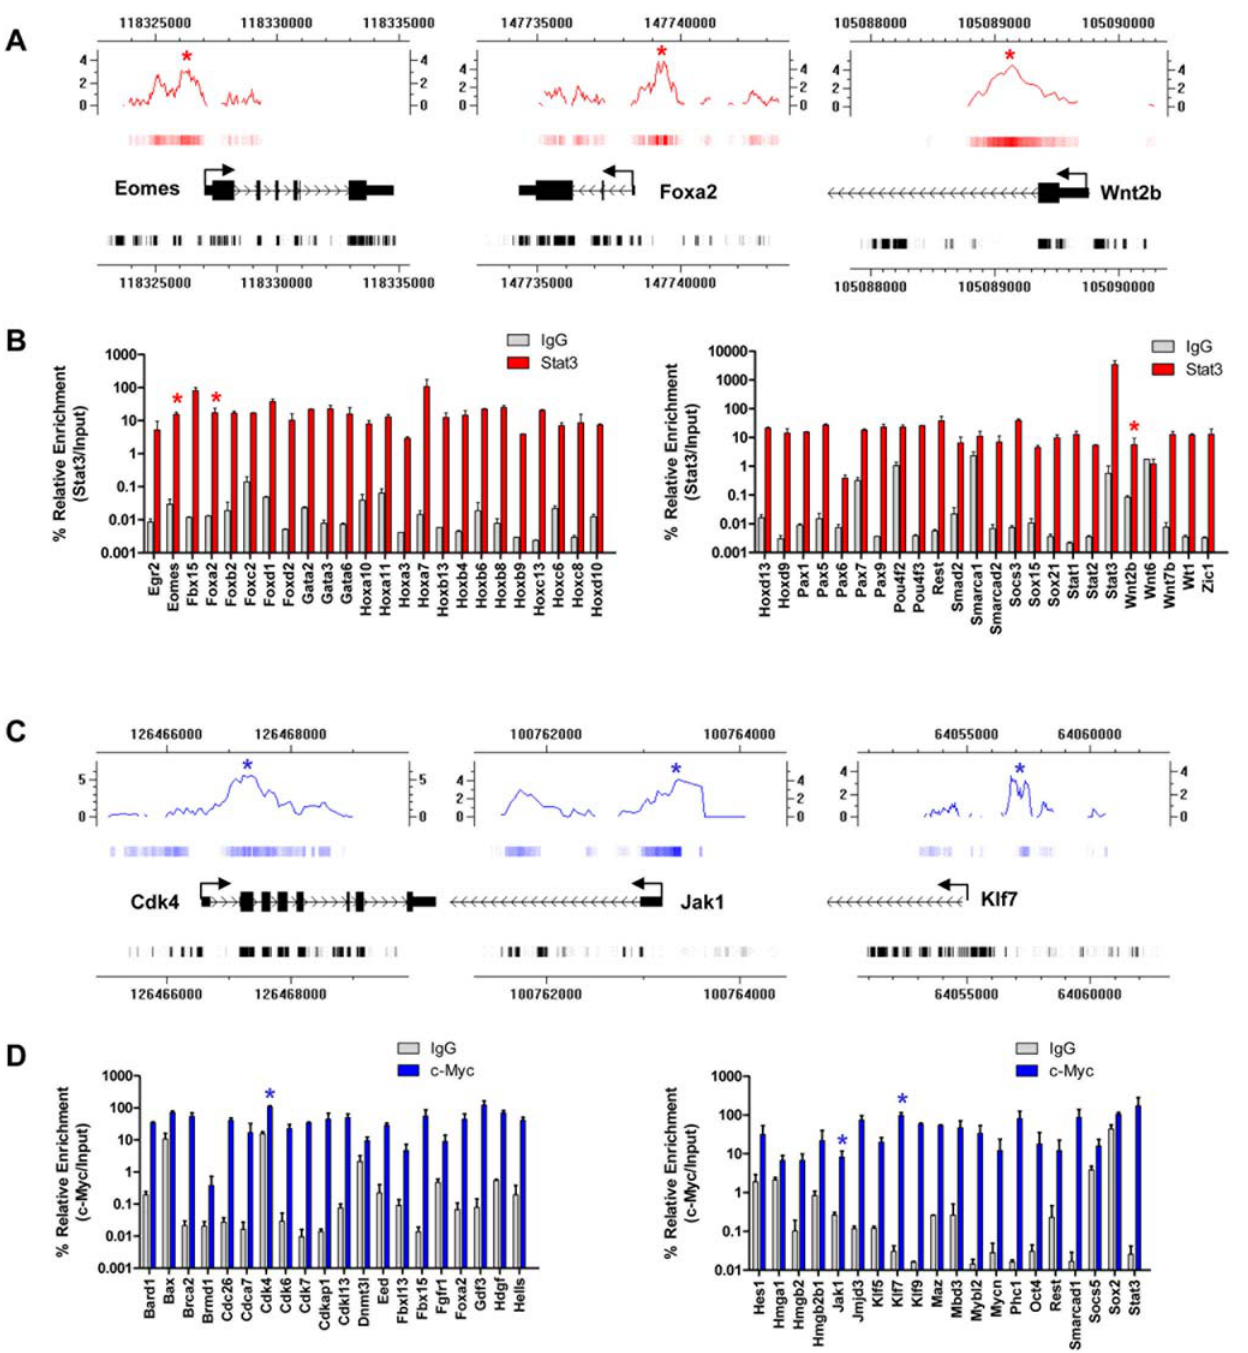
Figure 3. Q-PCR analysis of Stat3 and c-Myc ChIP-enriched regions. (A) Representative Stat3 genomic binding sites confirmed by Q-PCR. Red stars denote ChIP-chip enriched DNA sequences that were amplified using Q-PCR. (B) Confirmation of Stat3-ChIP enriched TF binding sites by Q-PCR. (C) Representative c-Myc genomic binding sites confirmed by Q-PCR. Blue stars denote ChIP-chip enriched DNA sequences that were amplified using Q-PCR. (D) Confirmation of c-Myc-ChIP enriched TF binding sites by Q-PCR. Q-PCR was performed on non-amplified Stat3-, c-Myc-, and IgG-ChIP enriched and Input DNA. Results are shown as percent enrichment relative to Input. MA enrichment values adjusted to log2 are shown in addition to sequence position. Stat3 and c-Myc enrichment are shown as red and blue heat maps respectively, while conservation is shown as a grayscale heat map.